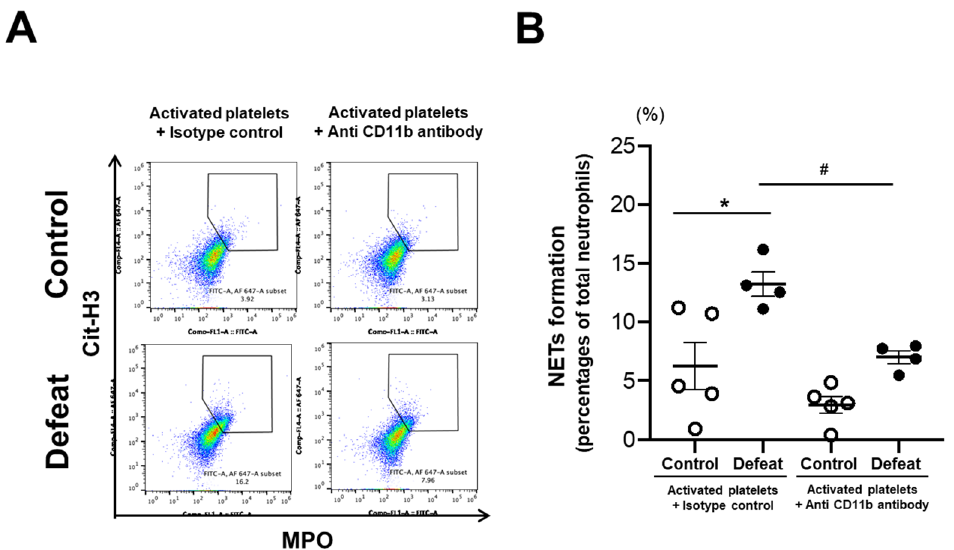
Figure 8. Anti-CD11b antibody treatment markedly inhibits NET formation of mature BM neutrophils in defeated mice. ( A ) Representative flow cytometry data showing Cit-H3- and MPO-positive cells in mature BM neutrophils from control and defeated mice with or without anti-CD11b antibody treatment. ( B ) Quantitative analysis of double-positive cells. Values represent mean ± standard error of mean (SEM) for five control neutrophils and four defeated mice neutrophils with isotype treatment and for five control neutrophils and four defeated mice neutrophils with anti-CD11b antibody treatment. * p < 0.05 vs. neutrophils from control mice with isotype treatment, # p < 0.05 vs. neutrophils from defeated mice with isotype treatment; two-way ANOVA with the Tukey–Kramer post hoc test. Cit-H3, citrullinated histone H3; MPO, myeloperoxidase.